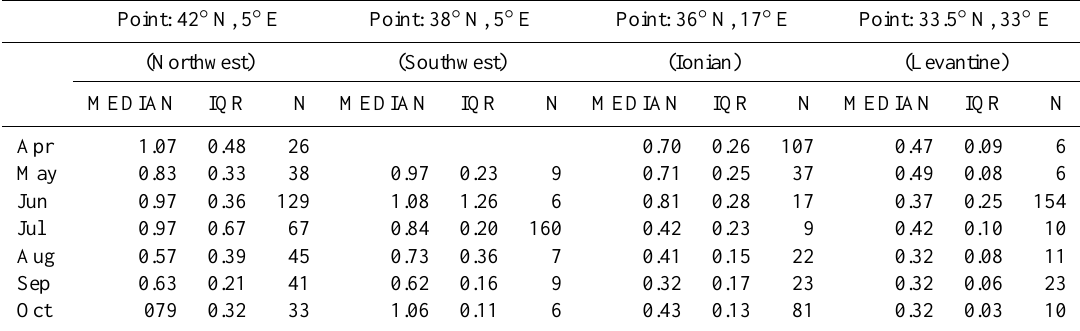
Table 2. Median and interquartile range (IQR) of [Chl a ] at DCM for each geographical location analyzed in Fig. 3 (i.e., yellow diamonds in Fig. 1). Median and IQR were computed by considering all the DCM depth [Chl a ] estimations extracted from available profiles of the DCM standard shape. IQR is the difference between the third and the first quartile.